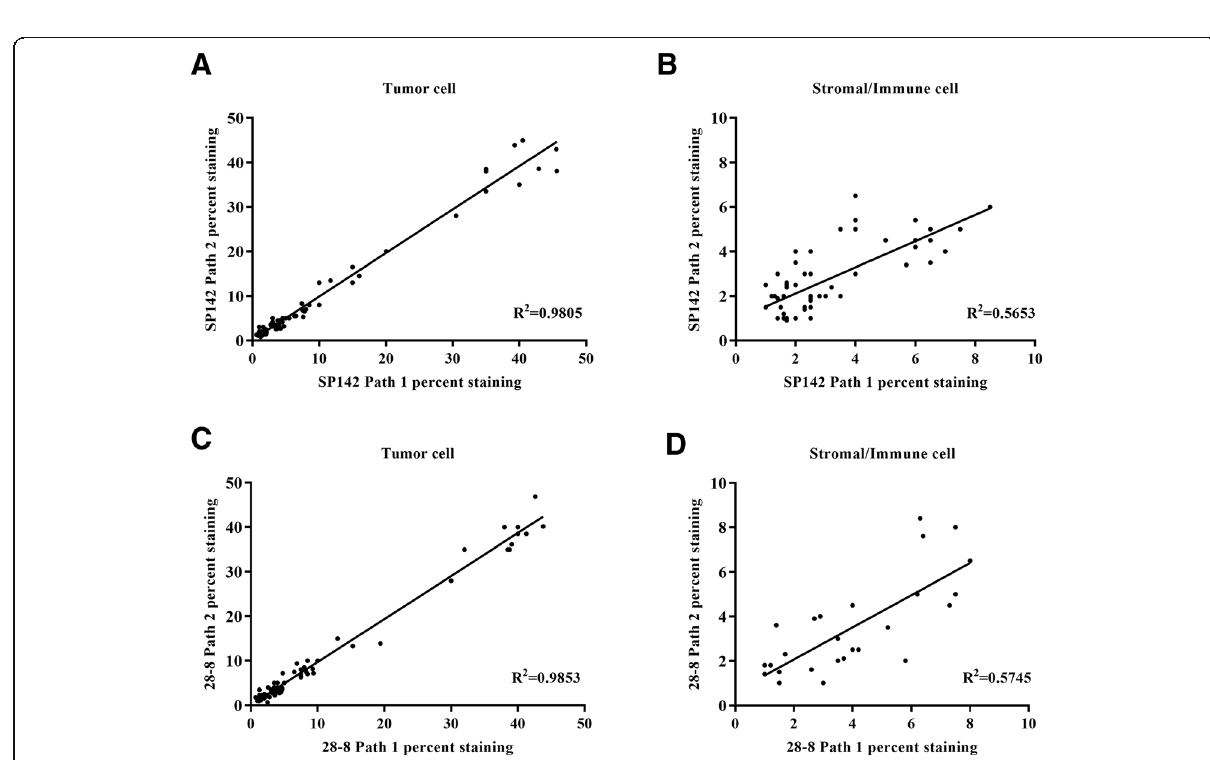
Fig. 4 Inter-pathologist correlation of clone SP142 and clone 28 – 8 PD-L1 expression analysis. Scatter plot comparing the percentage of positive PD-L1 expression in tumor cell ( a ) and stromal/immune cell ( b ) from pathologist 1 and 2 using clone SP142. Scatter plot comparing the percentage of positive PD-L1 expression in tumor cell ( c ) and stromal/immune cell ( d ) from pathologist 1 and 2 using clone 28 –